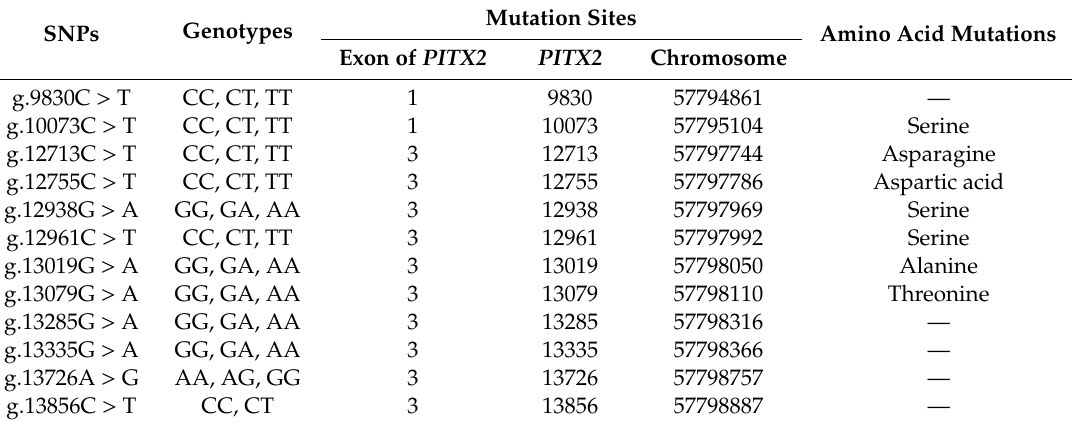
Table 2. Alleles and genotypes of single nucleotide polymorphisms (SNPs) in the exons of the PITX2 gene and the amino acid mutations.